Question: In a single sentence, describe what this figure presents.
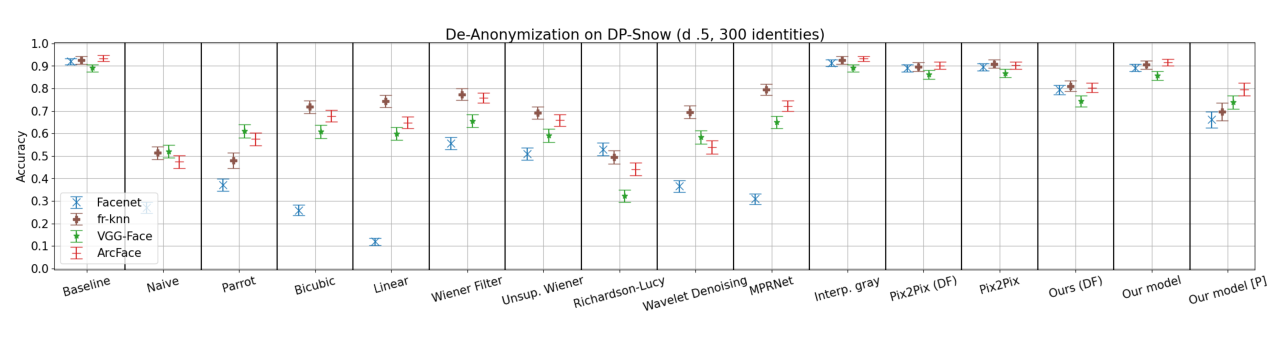
Answer: Recognition accuracy for DP Snow, given for baseline, naive, parrot, de-anon. via bicubic interpolation, via linear interpolation, via Wiener Filter, via unsupervised Wiener Filter, via Richardson-Lucy interpolation, via Wavelet Denoising, via MPRNet (Denoising), via Interpolate Gray, via Pix2Pix trained on DigiFace-1M, via Pix2Pix, via our model trained on DigiFace-1M, via our model; on 300 identities of CelebA.